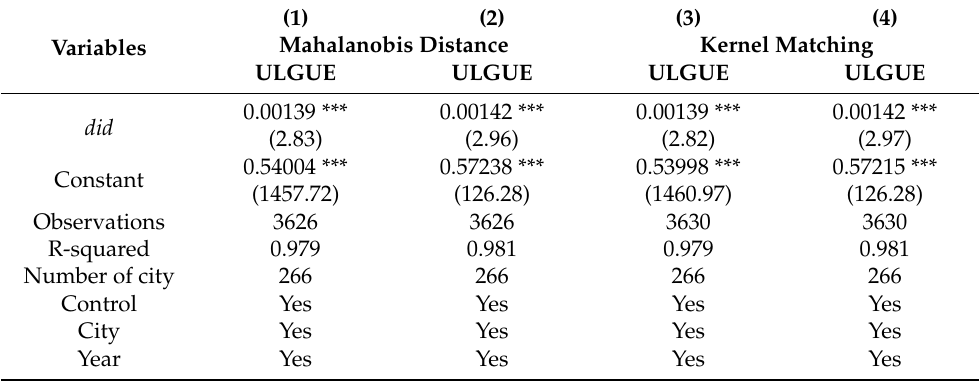
Table 6. PSM-DID regression results.